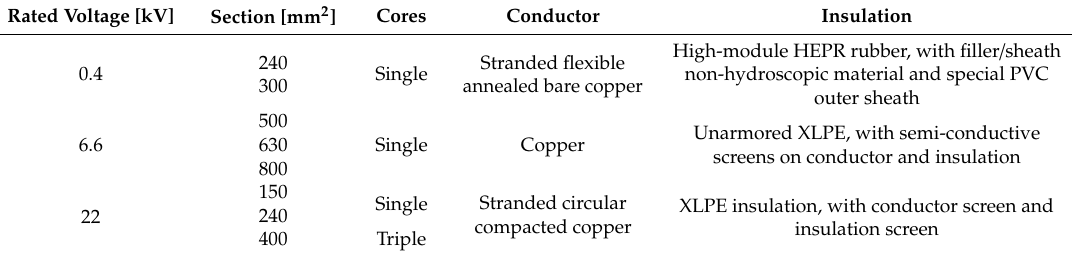
Table 6. Materials and technical characteristics assumed for the SSEN